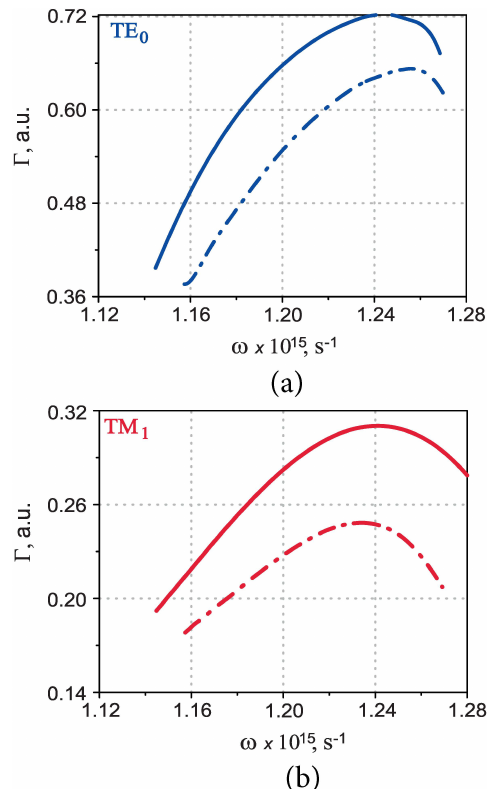
Figure 5: Variation of the confinement factor Γ versus frequency ω for several guided modes: (a) TE 0 modes; (b) TM 1 modes. Here solid curves correspond to periodic cladding, while dashed curves correspond to aperiodic cladding. In all cases, N = 10